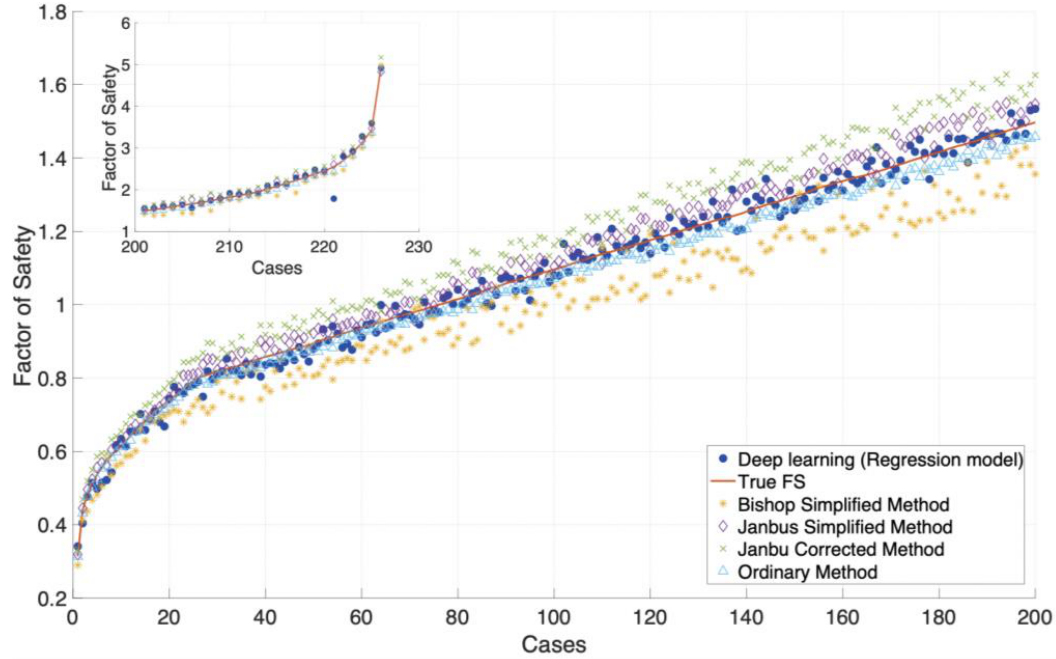
Figure 10. The comparison between LEMs and the regression model.